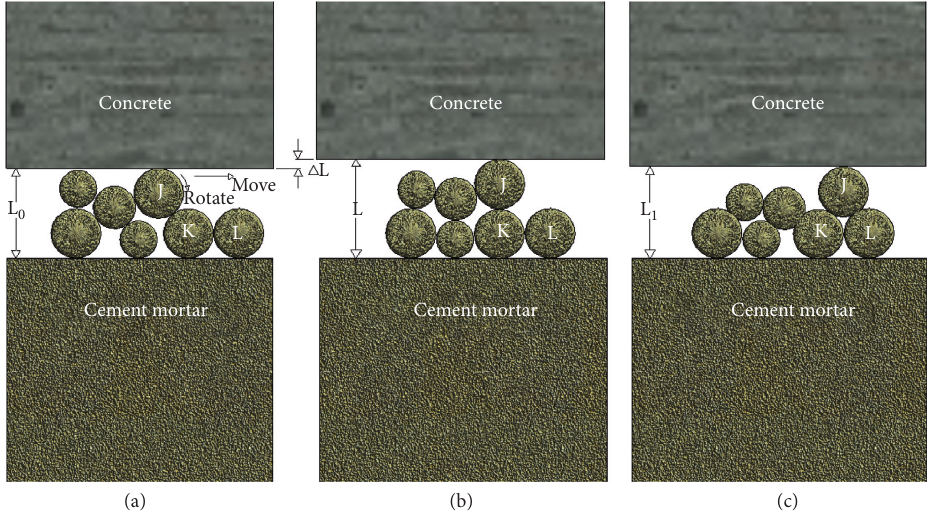
Figure 8: Conceptual model of the interface layer.